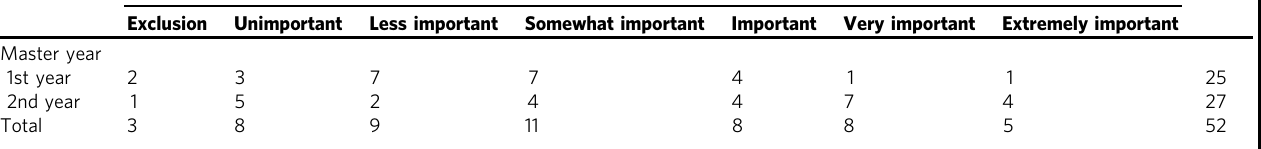
Table 10 Contingency table with the description of the rank score for Question 1. ( ‘ History Class must …’ ), option B ( ‘… employ several pedagogical resources and strategies that can motivate students. ’ ) according to the study year of the Master ’ s Degree students.